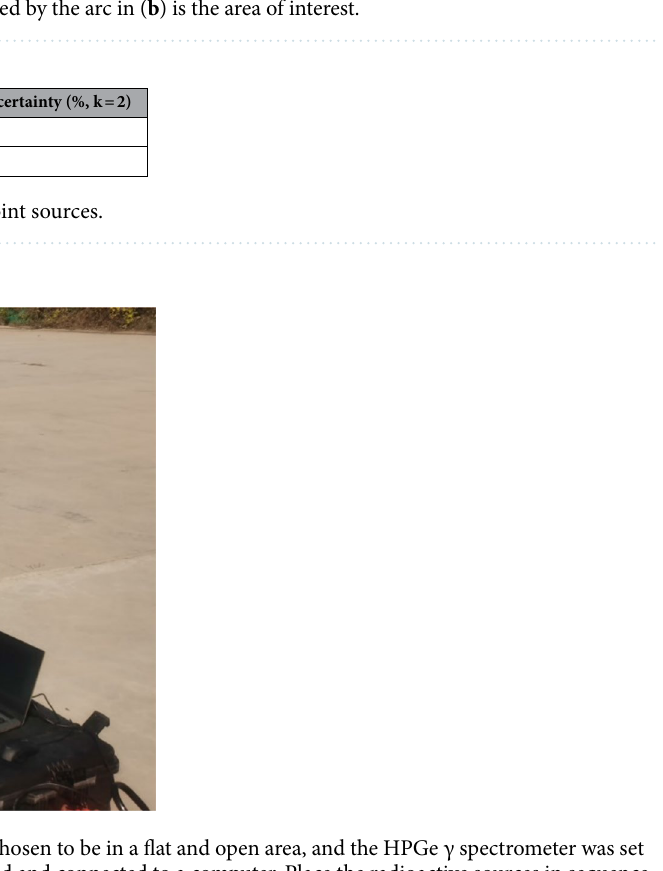
Figure 6. Simulation of uniformly distributed surface sources using the grid layout method. ( a ) shows the meshing principle, and the part enclosed by the arc in ( b ) is the area of interest.